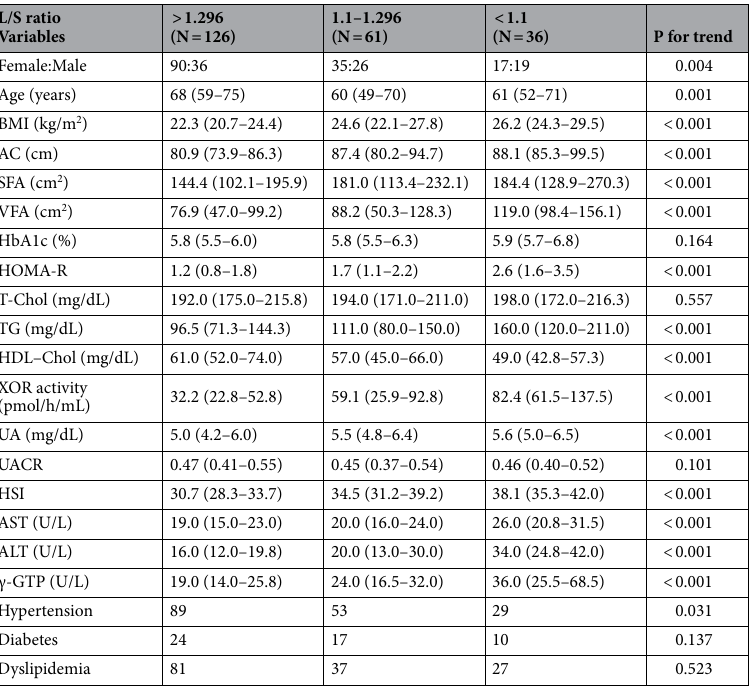
Table 2. Differences in clinical parameters based on liver-to-spleen (L/S) ratio. Clinical parameters and the proportion of comorbidities among the three groups were examined using Jonckheere–Terpstra test or Cochran–Armitage test. BMI, body mass index; AC, abdominal circumference; SFA, subcutaneous fat area; visceral fat area, VFA; HbA1c, hemoglobin A1c; HOMA-R, homeostasis model assessment ratio; T-Chol, total-cholesterol; TG, triglycerides; HDL-Chol, high-density lipoprotein-cholesterol; UA, uric acid; UACR, urine uric acid to creatinine ratio; HSI, hepatic steatosis index; AST, aspartate transaminase; ALT, alanine transaminase: γ-GTP, γ-glutamyl